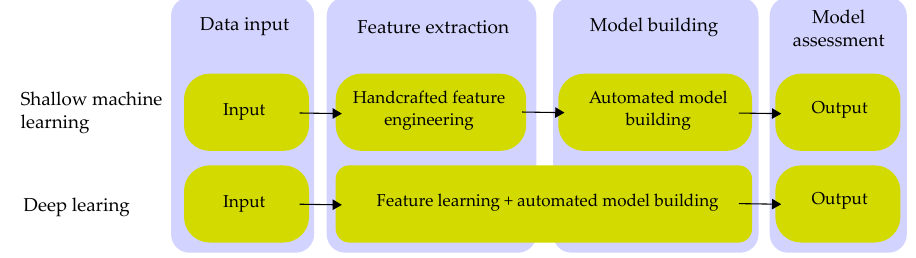
Figure 1. Differences between ML and DL approach [24].